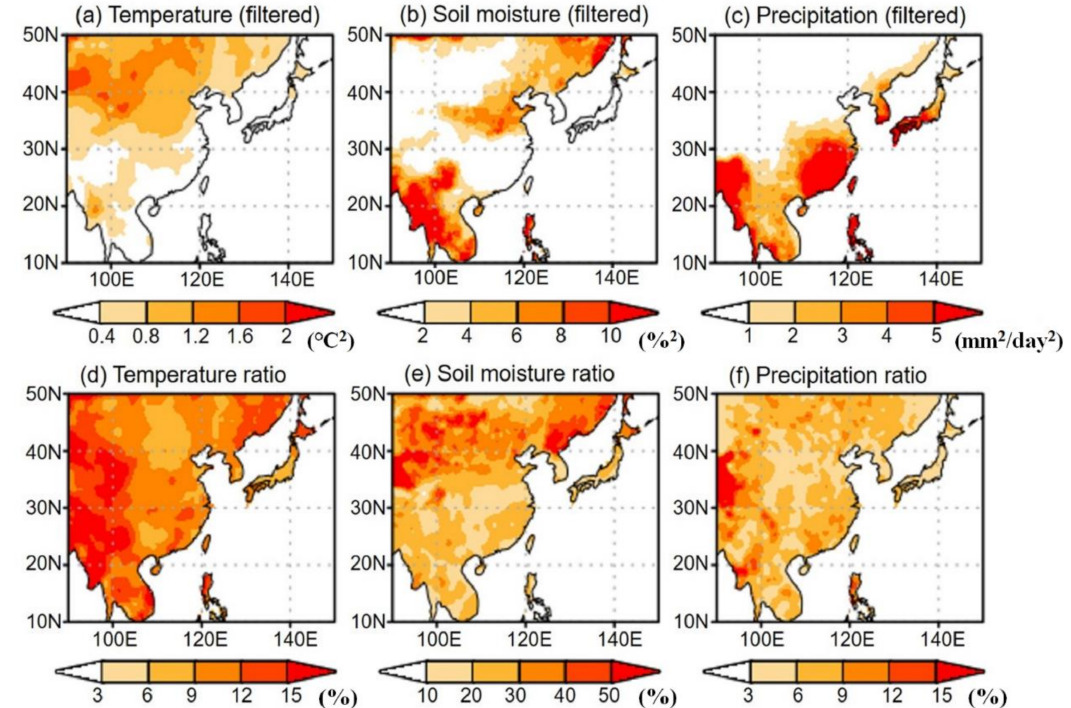
Figure 4. Variance of ( a ) SAT, ( b ) near-surface volumetric soil moisture, and ( c ) precipitation bandpass filtered for 30–90 days during 22 springs between 1991–2012, and ( d – f ) their ratios to total variance,